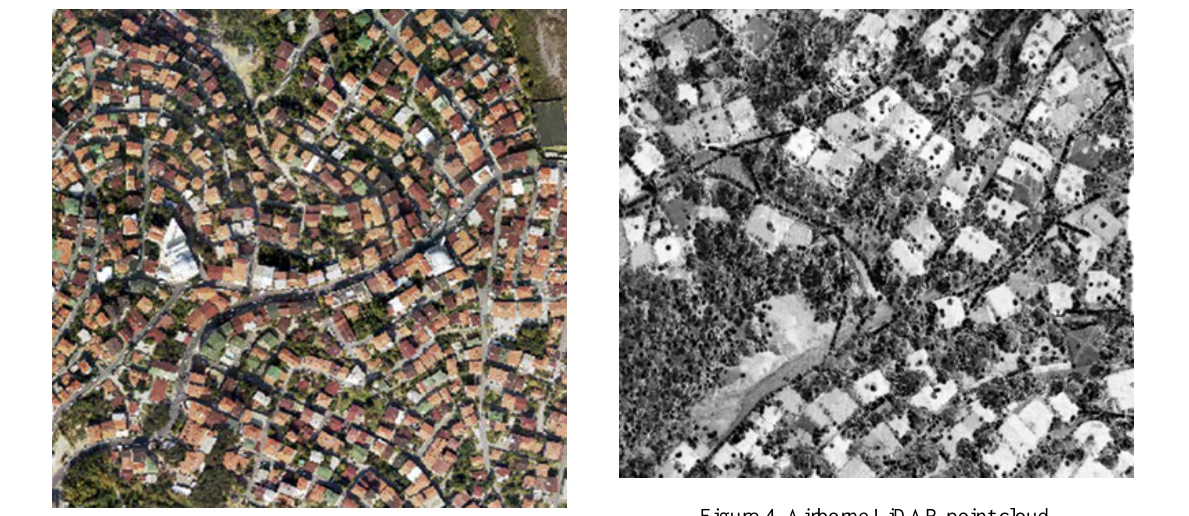
Figure 2. RGB bands image